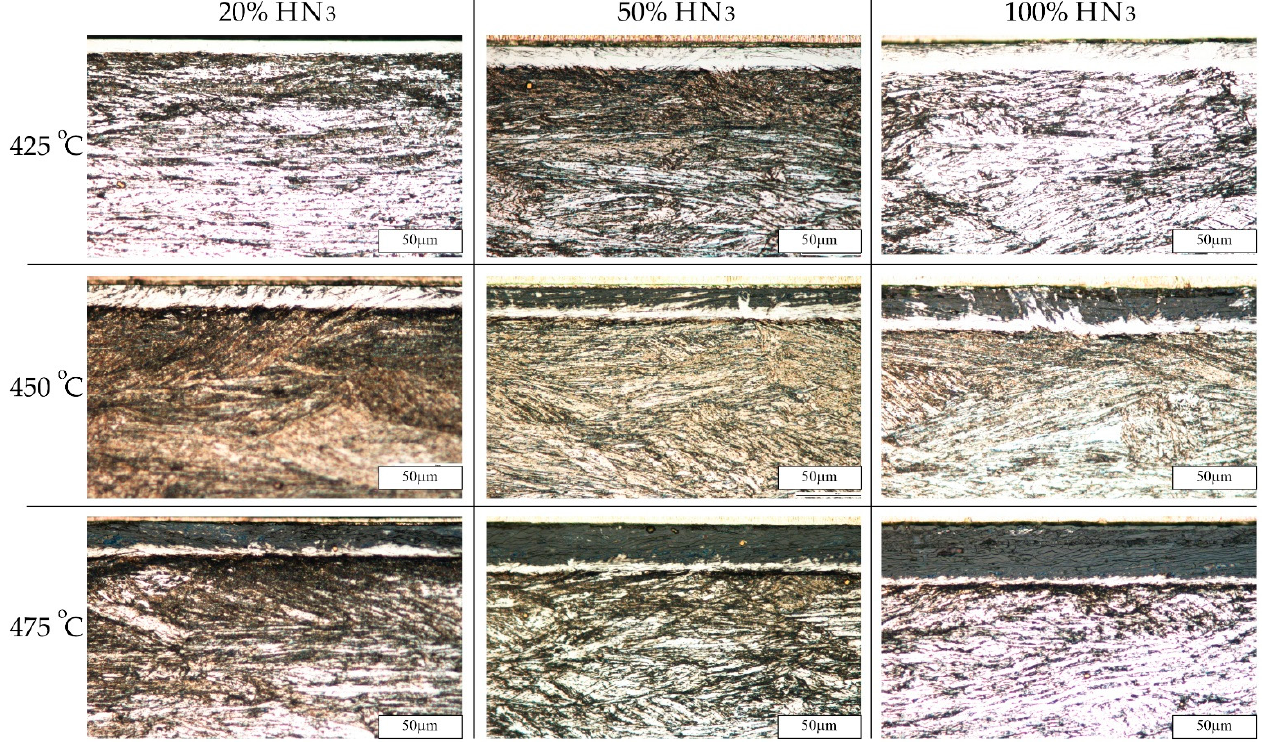
Figure 3. Cross sections of nitrided layers obtained at various temperatures and atmospheres with a constant nitriding time of 4 h. Light microscopy.